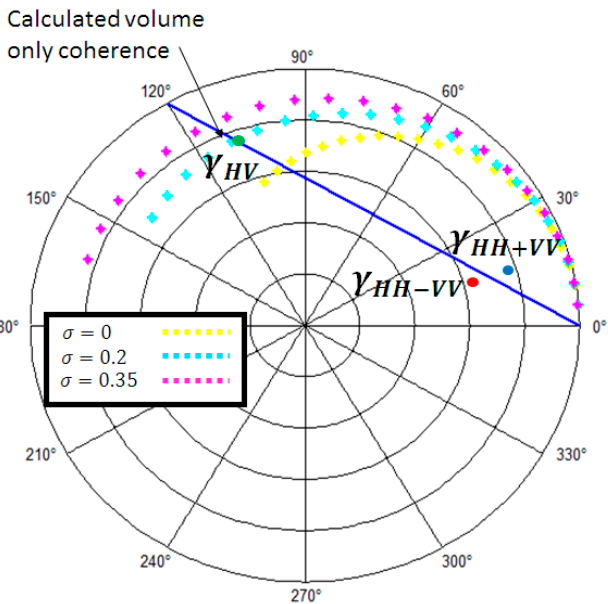
Figure 3. A schematic representation of the last step of the three-stage method. The blue line is the coherence line and the complex coherences on the Pauli basis are represented by blue, red, and green circles.